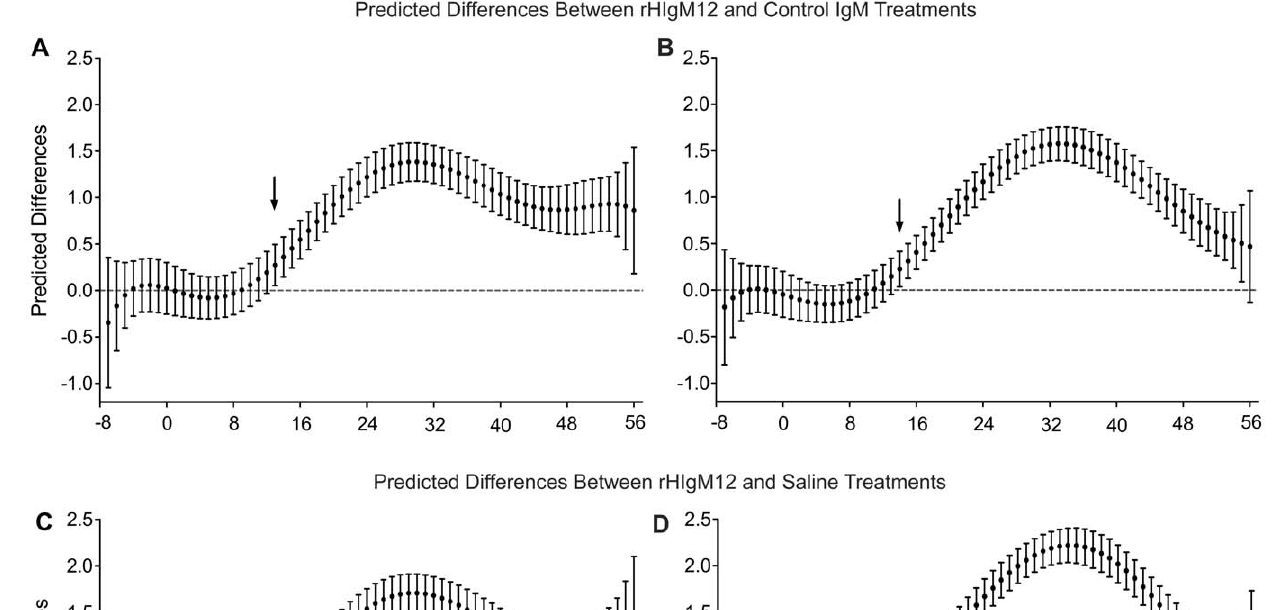
decline in spontaneous activity. This result indicates that none of the antibodies has an influence on increasing activity in normal mice.